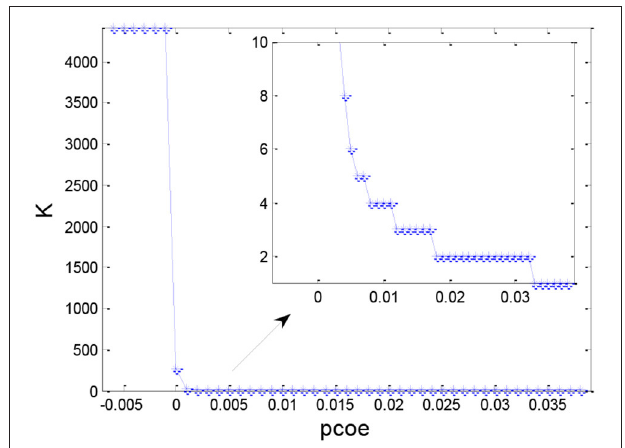
FIGURE 7 | Distribution of the number of clusters for different values of p c